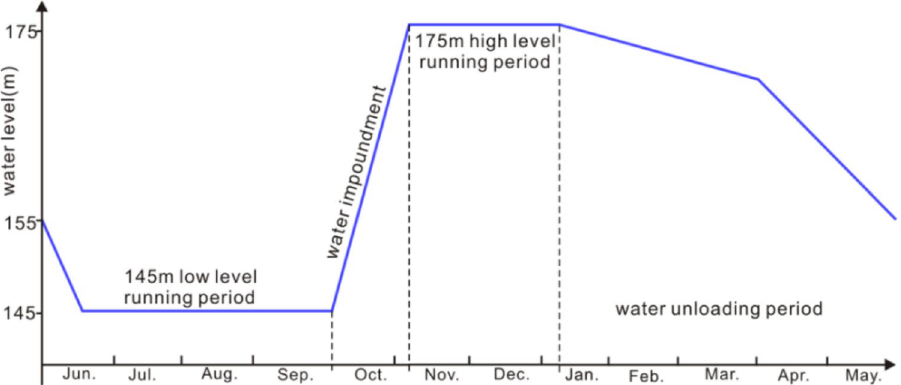
Figure 2. Reservoir water level planning curve in the Three Gorges